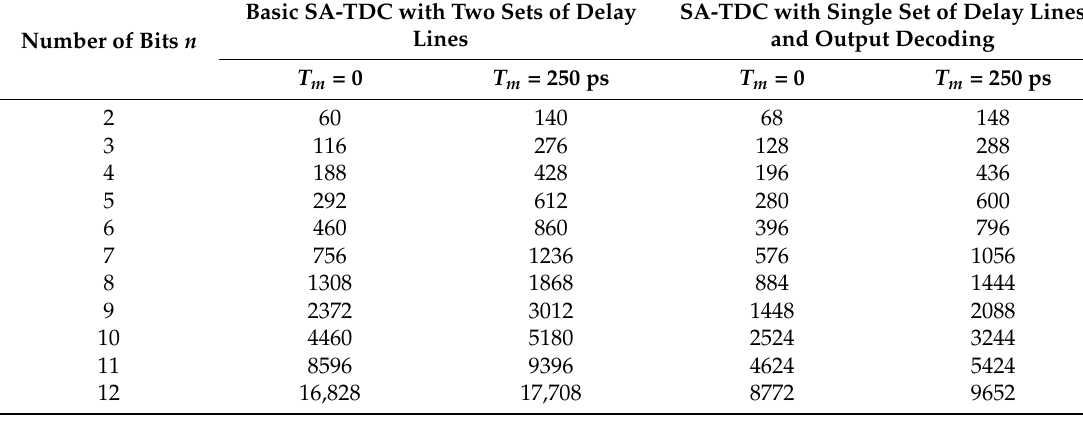
Table 1. Number of transistors in n -bit SA-TDC with two sets of delay lines, and with single set of delay lines and output decoding for T m = 0 and T m = 250 ps .